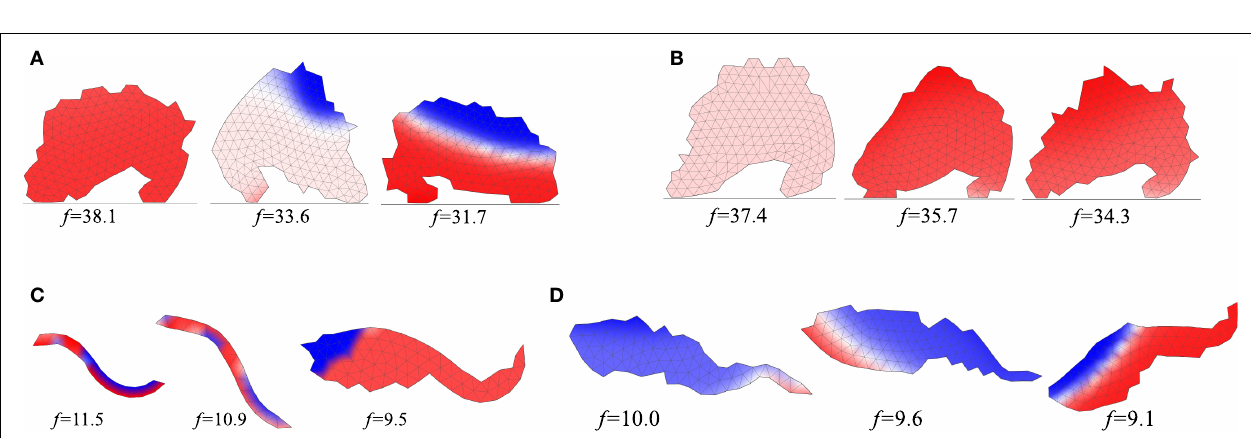
FIGURE 4 | Morphologies of terrestrial individuals relying on oscillator-driven actuation evolved using NEAT (A) and novelty search (B) and their corresponding fitnesses . The five best individuals obtained using each search method are shown. Colors indicate evolved phase shifts of muscular contractions (blue) or expansions (red). Example motion video is linked in the caption of Figure 2 .